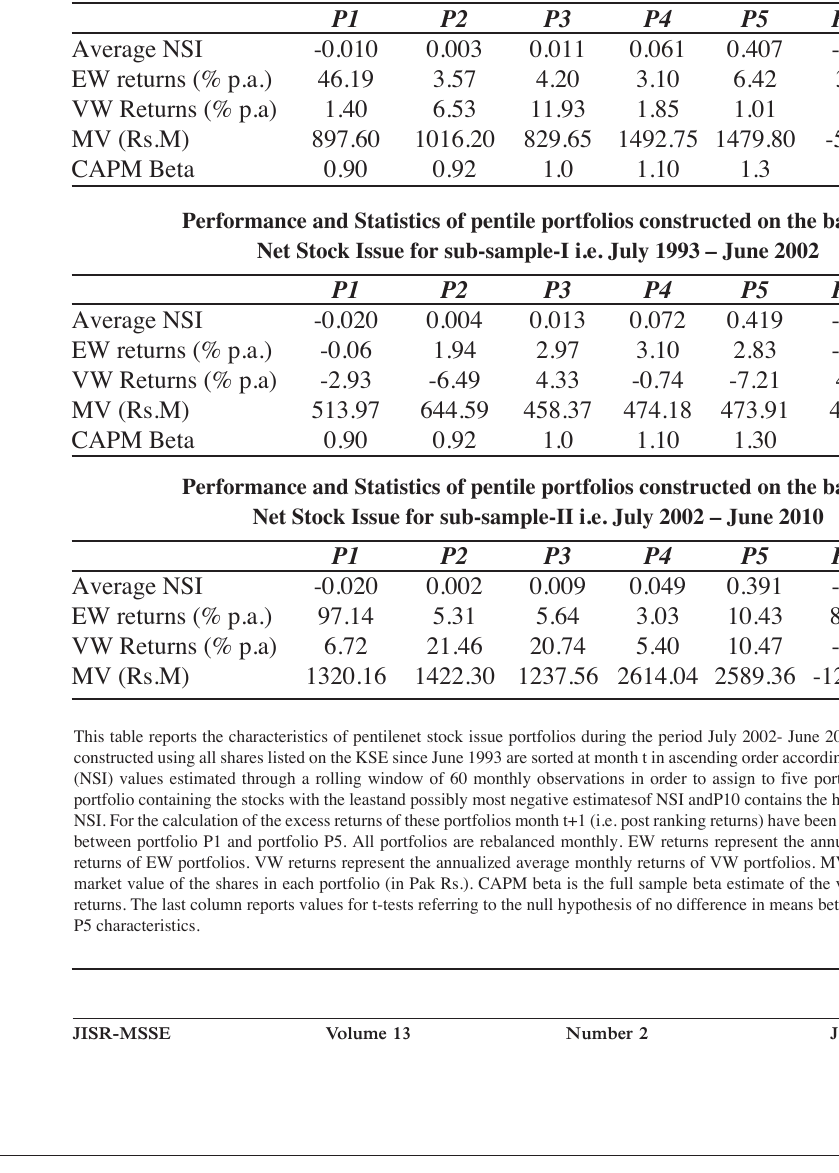
Performance and Statistics of pentile portfolios constructed on the basis of Net Stock Issue for All Sample i.e. July 1993 – June 2010